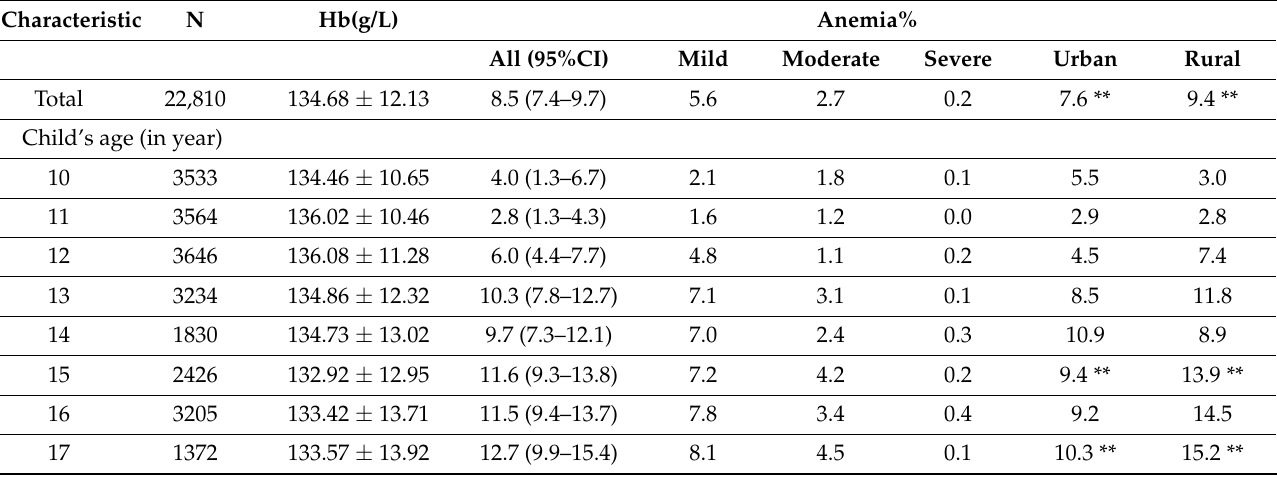
Table 1. Hemoglobin and anemia status of adolescent